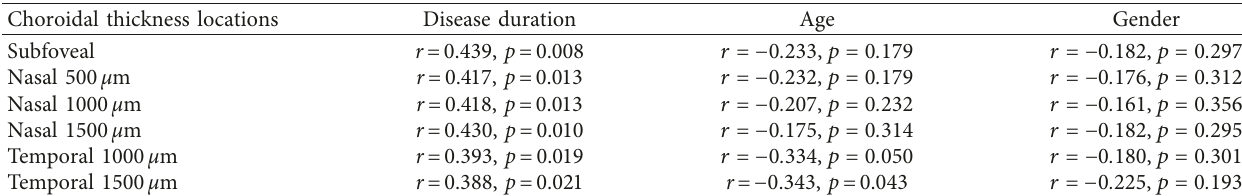
Figure 4: Choroidal thickness measurements. The values above the boxes show statistical significance when comparing the choroidal thickness measurements of the coeliac and control groups. Table 3: Correlation coefficient results in the coeliac